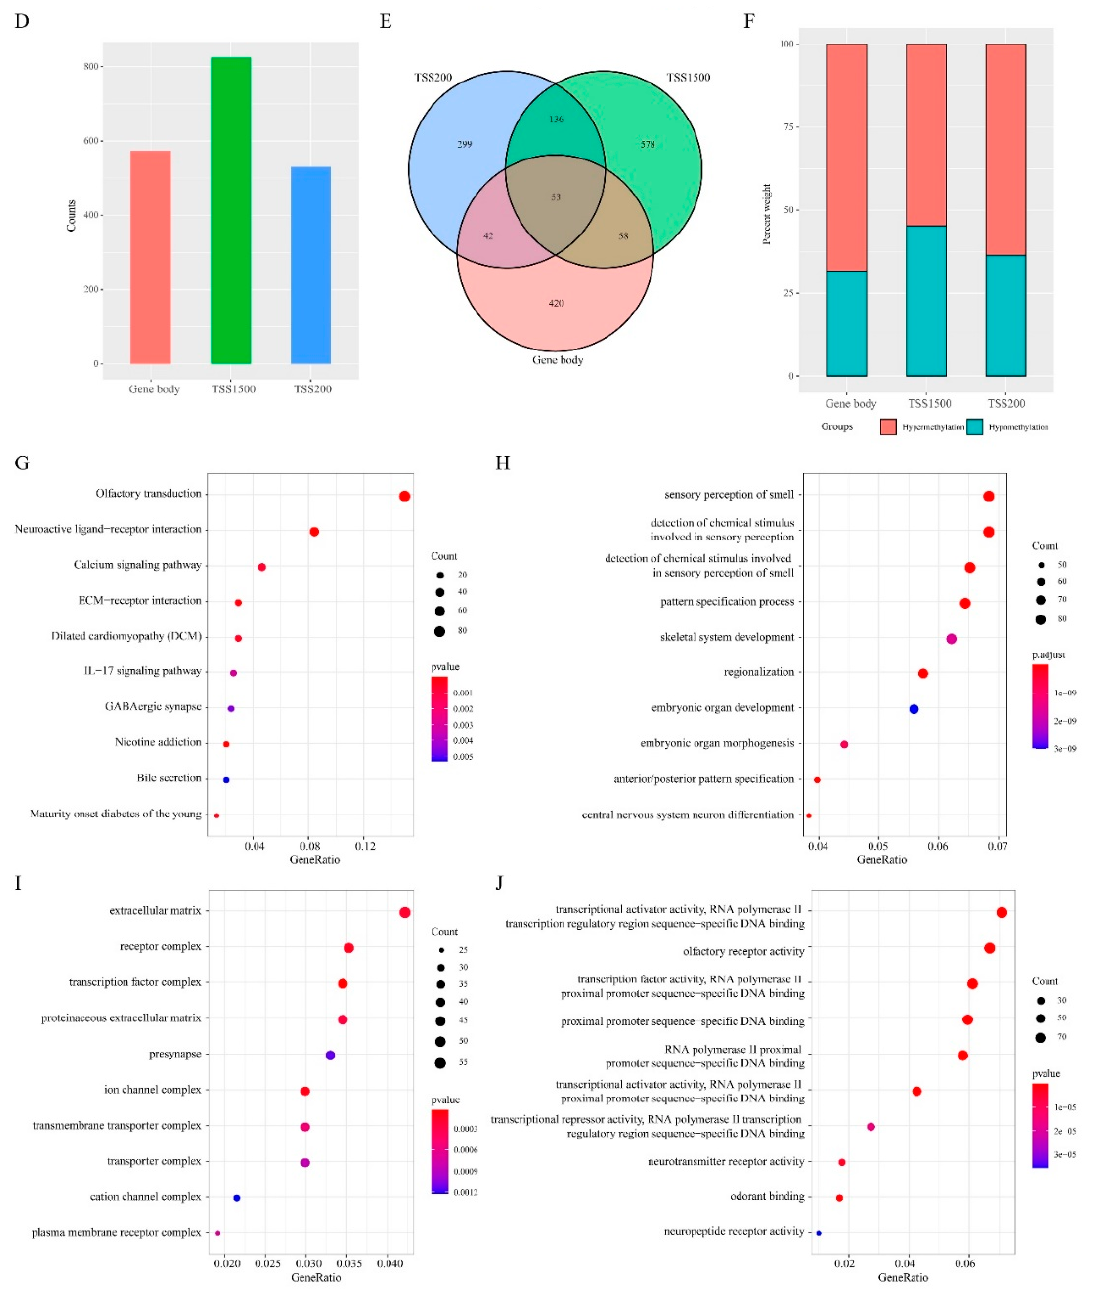
Figure 1. Di ff erentially methylated genes (DMGs) in “Epidermal growth factor receptor (EGFR) Wild Type/Low PD-L1 expression” non-small cell lung cancer (NSCLC). ( A – C ) Volcano plots showing the distribution of DMGs in TSS200, TSS1500 and gene body regions, respectively. ( D ) Histogram showing the amount of DMGs in gene body ( n = 573), TSS1500 ( n = 825) and TSS200 ( n = 530) regions. ( E ) Venn map of DMGs in three di ff erent regions. ( F ) Histogram showing the percentage of hypermethylated and hypomethylated DMGs in three di ff erent regions. ( G ) Top 10 Kyoto Encyclopedia of Genes and Genomes (KEGG) enrichment pathways of DMGs in three regions. ( H ) Top 10 Gene Ontology (GO) Biological Process (BP) terms of DMGs in three regions. ( I ) GO cellular component (CC) terms of DMGs in three regions. ( J ) GO molecular functions (MF) terms of DMGs in three regions. The size of the dots represents the number of genes enriched in the pathway, and the colors correspond to di ff erent false discovery rate (FDR) values.